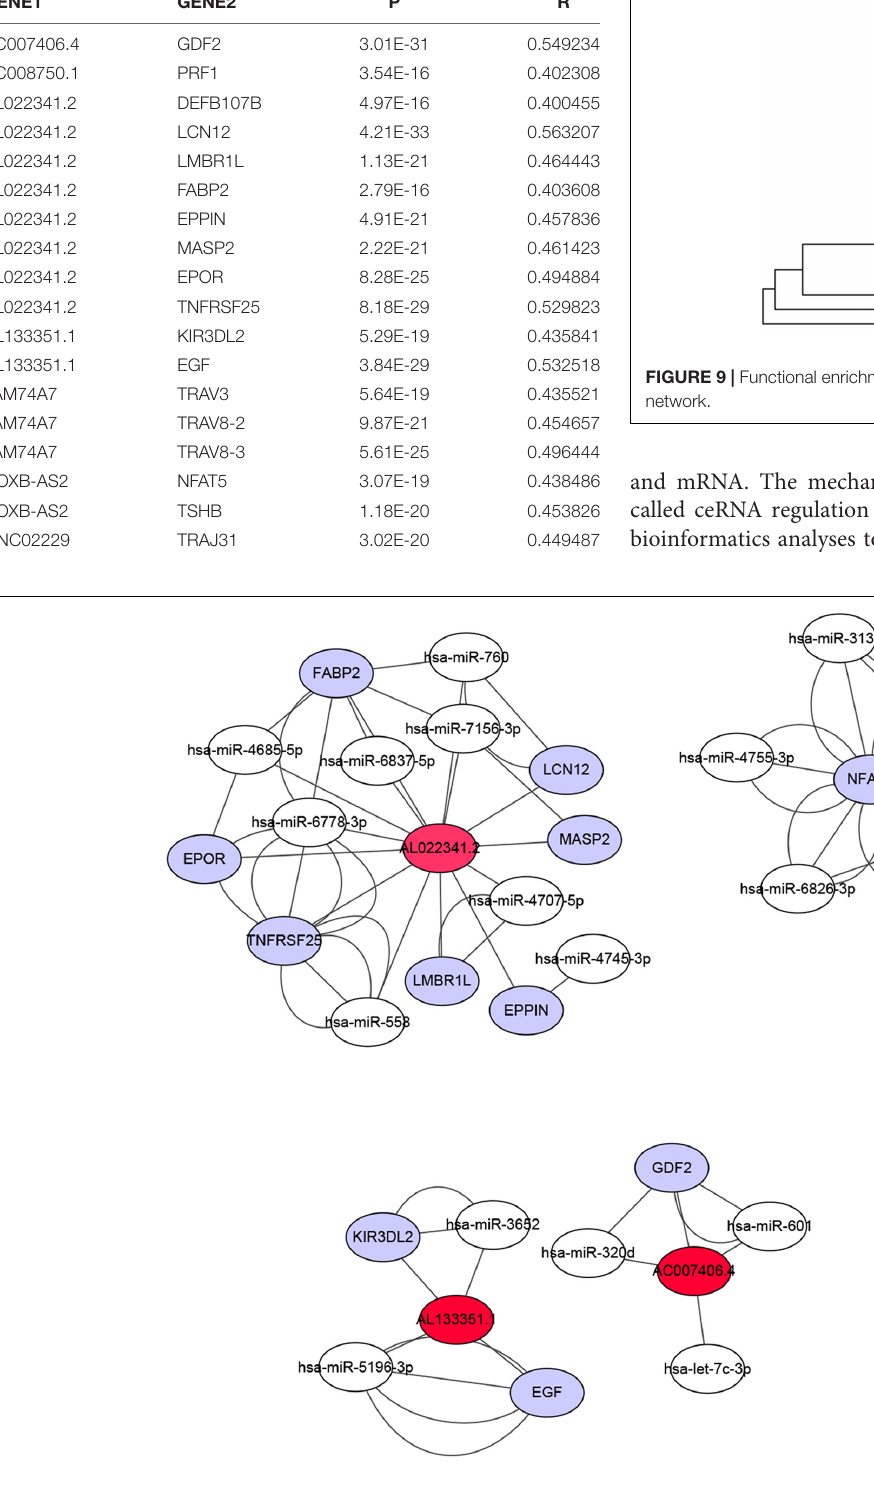
FIGURE 8 | Construction of a ceRNA network associated with the immune-related lncRNAs. The ceRNA network included four immune-related lncRNAs, 11 immune-related genes, and 18 miRNAs. Red represents lncRNA, white represents miRNA, and purple represents mRNA.